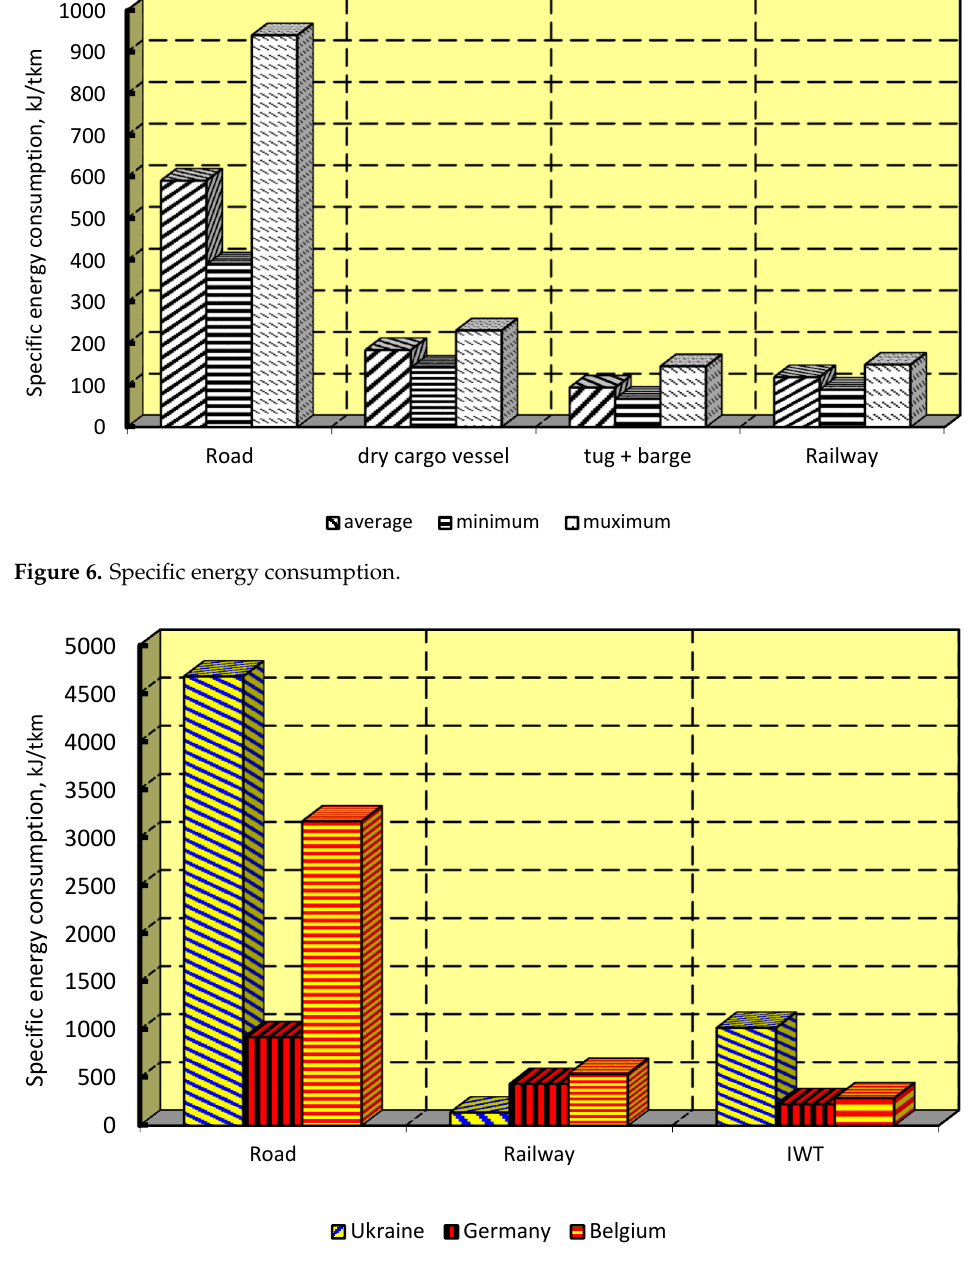
Figure 7. Actual specific energy consumption.